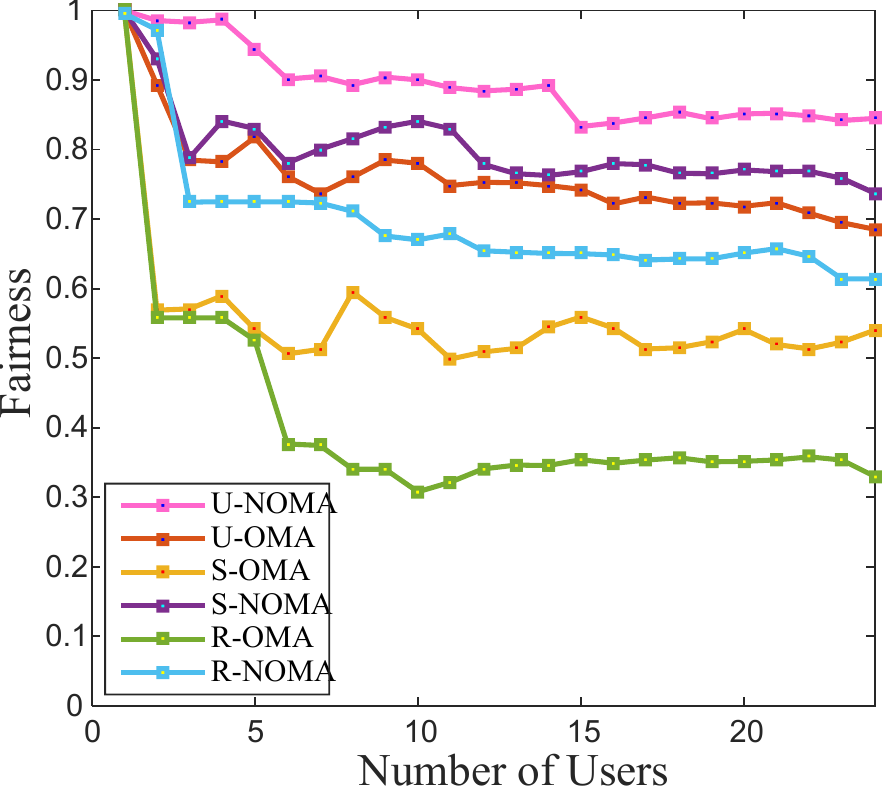
Figure 3. Fairness factor of various schemes for a different number of total users in the cell.